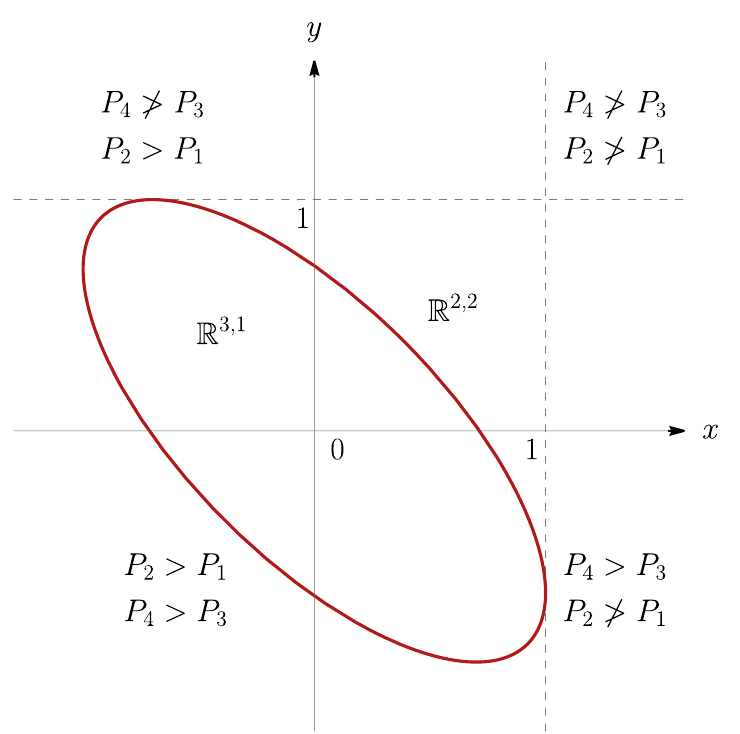
Figure 9 . A plot of the causal and R p,q structure of the neighbourhood of the Regge point. The red line in this plot represents the boundary between R 3 , 1 and R 2 , 2 for a typical value of θ . R 3 , 1 region is represented by the deep blue shaded region. P causal future of P or not respectively. The two dashed lines divide the plane into four distinct j causal